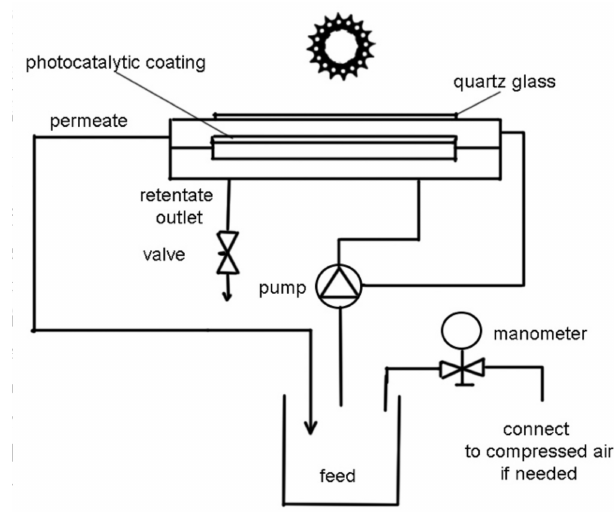
Figure 6. Schematic diagram of PMR utilizing a PM with the photoactive support layer